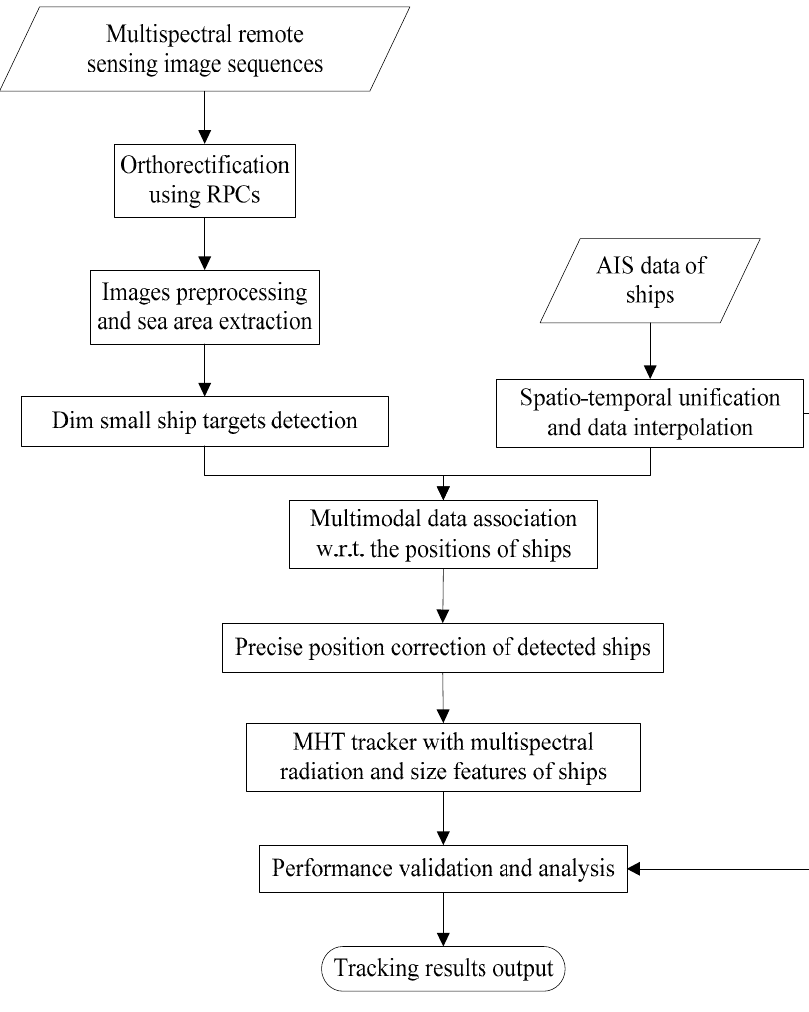
Figure 1. The fl owchart of the proposed method. Figure 1. The flowchart of the proposed method.